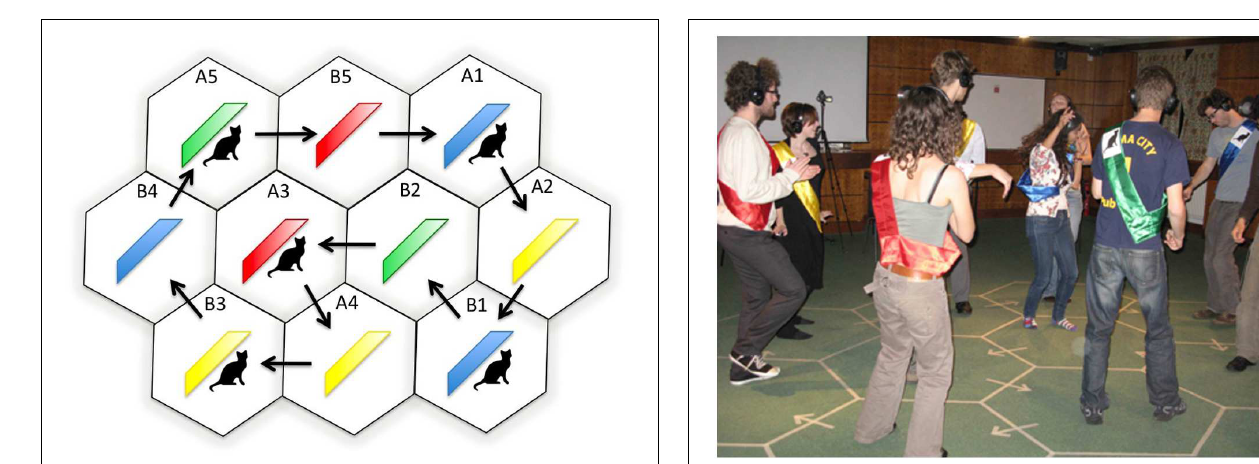
FIGURE 3 | Photograph of the participants taken during the experiment; note the silent-disco radio headphones, sashes, symbols, and marked up hexagonal dance floor used to control the proximity of the